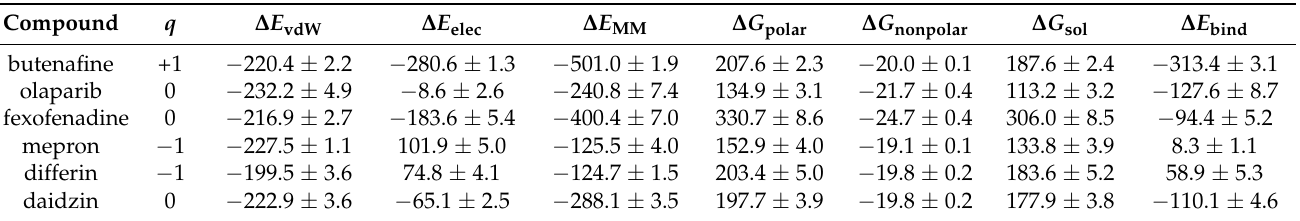
Table 4. Decomposition of binding energies (kJ/mol) of the selected inhibitors with ALDH2 via MM-PBSA using simulation